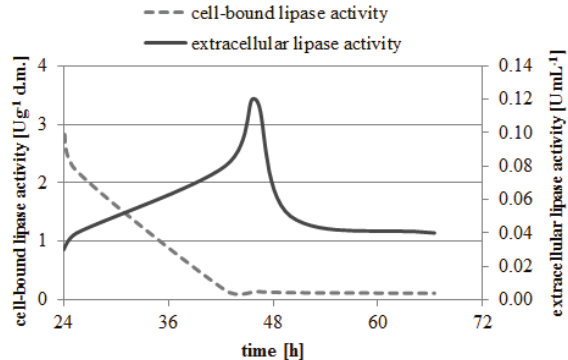
Fig. 3 – Activity of Y. lipolytica cell-bound and extracellular lipases during batch